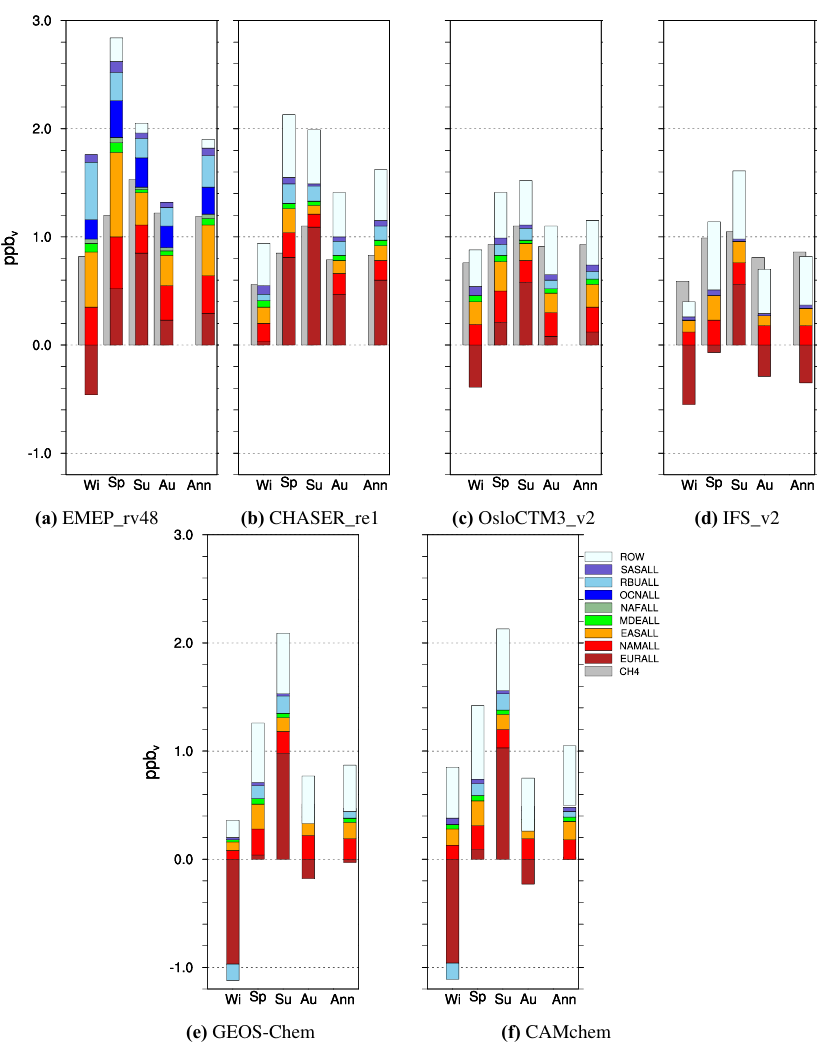
Figure 5. Contributions to European ozone levels (in ppb) from different world regions. WI is December, January, February. SP is March, April, May. SU is June, July, August. AU is September, October, November. Note that the separate contribution from northern Africa (NAFALL) and ocean shipping (OCNALL) is only included in the EMEP_rv48 model calculations (a) . The Middle East (MDEALL) and Russia, Belarus and Ukraine (RBUALL) are not included in the IFS_v2 model (d) . For all models, contributions from missing regions are included as ROW (rest of the world). Note that the areas included in ROW are model dependent. For the four top row models the effects of a 20% increase in CH 4 are shown as a separate